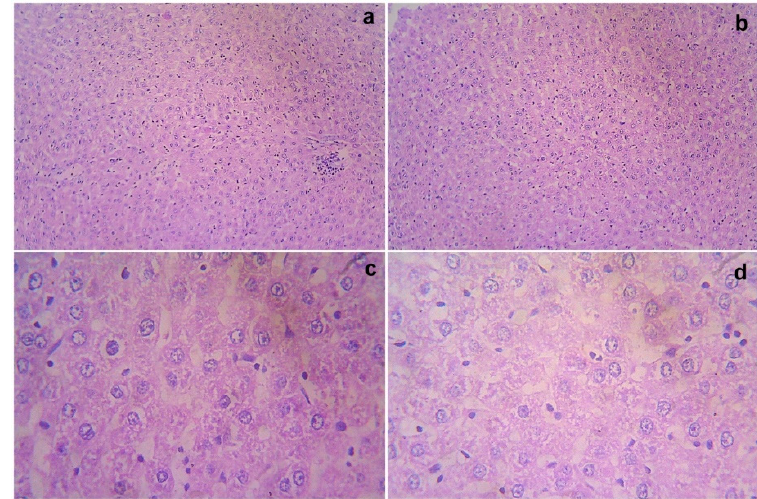
Figure 2. Gross histopathological examination of the liver following the infusion of mesenchymal stem cells obtained from decidua basalis in Wistar albino rats to assess the impact of safety, efficacy, and acute toxicity. Representative images of the liver section stand for ( a ) 10× showing central vein and sinusoidal dilatation, ( b ) 10× showing lobular architecture, ( c ) 40× showing focal necrosis, and ( d ) 40× showing cytoplasmic vacuolation and necrosis, respectively.